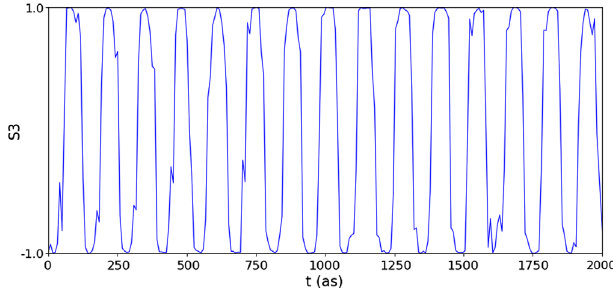
FIG. 5. The on-axis normalized Stokes parameter s 3 as a function of relative time t after 36 undulator-chicane modules. It is seen that s 3 flips between positive and negative values with extremes at j s 3 j ≈ 1 . 0 , indicating high degree of polarization